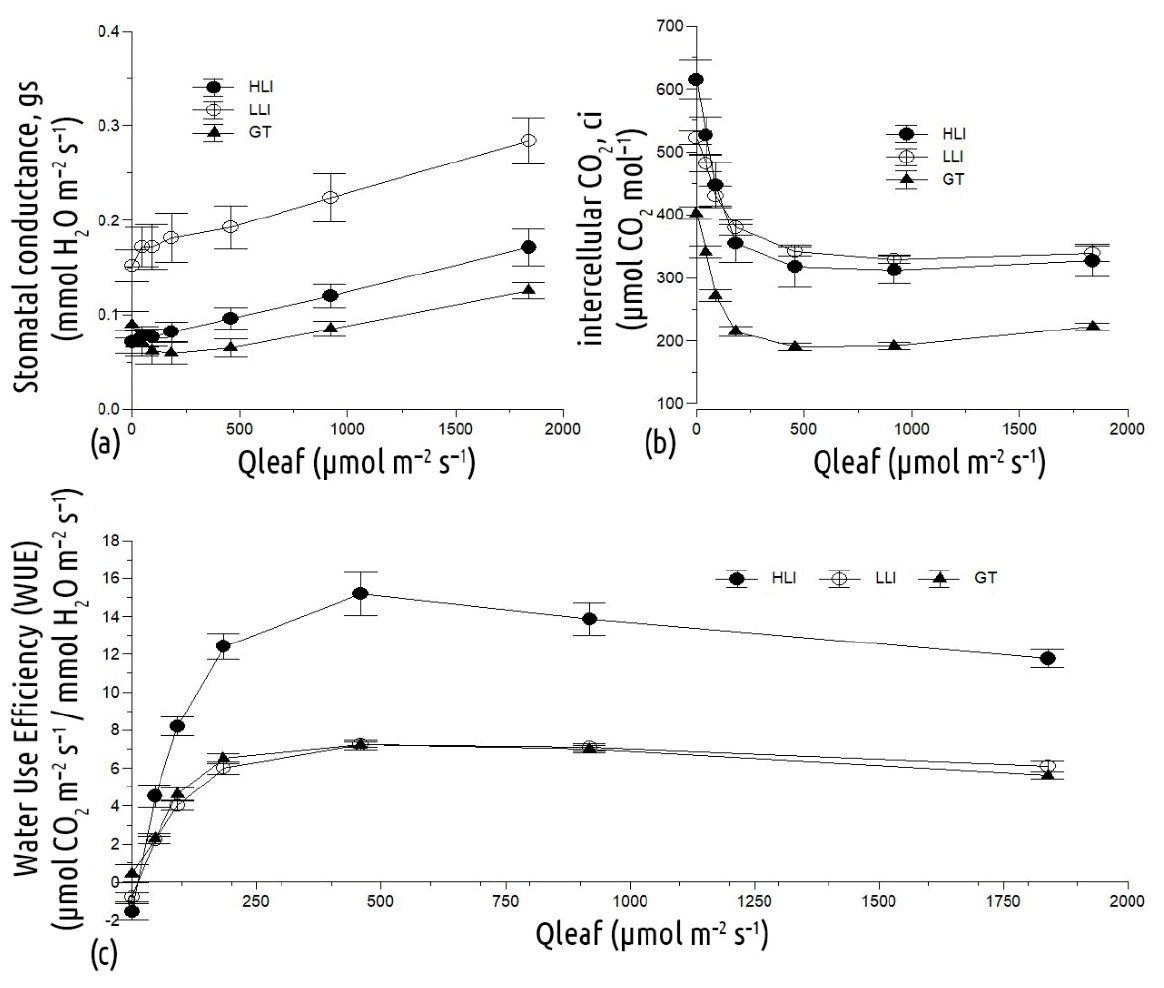
Figure 6. Stomatal conductance, gs, ( a ) intercellular CO 2 , ci, ( b , c ) water use efficiency (WUE) of an average lettuce grown under each treatment’s conditions. HLI, High light intensity; LLI, Low light intensity; GT, Glasshouse treatment. Vertical bars indicate ± standard errors of means.